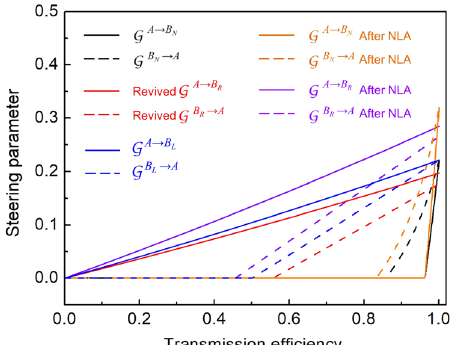
Fig. 6 Results for distillation of Gaussian steering with a correlated noisy channel and measurement-based NLA. Black solid and dash curves are the theoretical predicted steerabilities in a noisy channel with excess noise fi ve times of vacuum noise. Red solid and dash curves are the predicted steerabilities after revival of Gaussian steering with a correlated noisy channel. The orange and purple curves are the predicted steerabilities when the measurement-based NLA based on Bob ’ s measurement results with gain of 1.2 is applied before and after the revival of Gaussian steering, respectively. The blue solid and dash curves are the predicted steerabilities in a pure lossy but noiseless